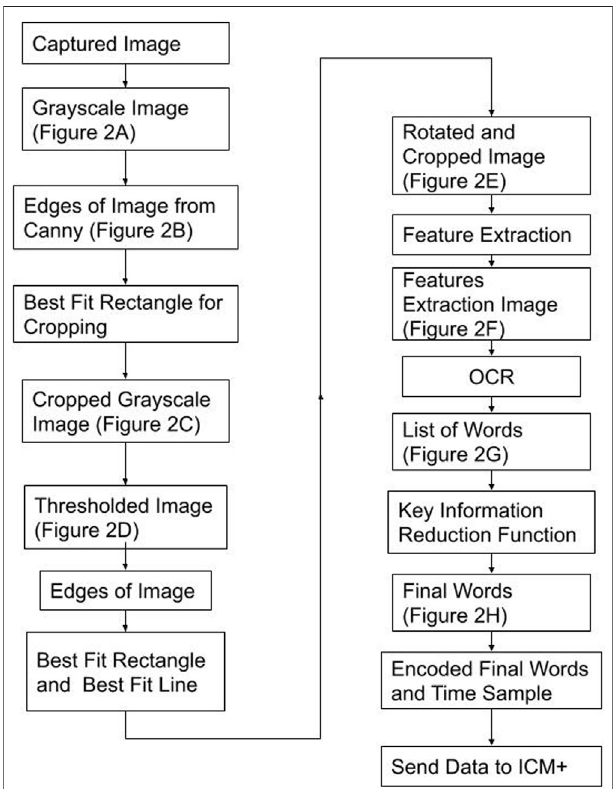
FIGURE 4 | Process Map – From Image Capture to Serial Output Figure displays the process taken to convert the image into its digital information and the steps to send the data to ICM+ (data acquisition platform). The best fi t rectangles and line are the key shapes used to crop and rotate the image. Feature Extraction is a Google Tesseract function to fi nd key shapes. Key Information Reduction Function is a function used to fi nd and order the alphanumeric of